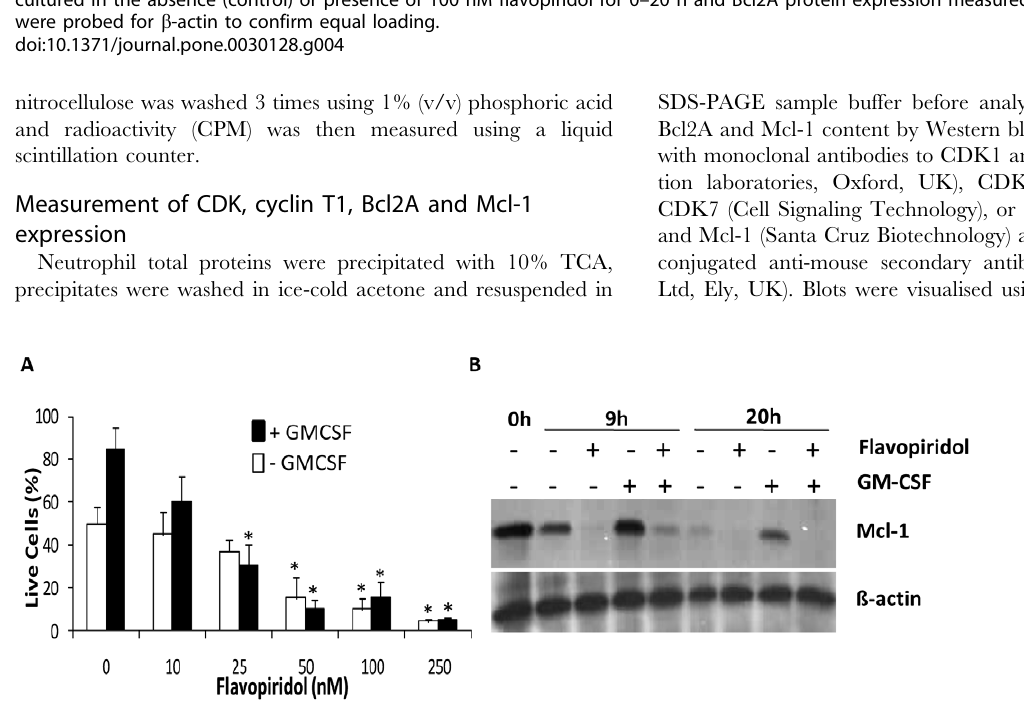
Figure 5. Flavopiridol inhibits upregulation of Mcl-1 by GM-CSF. (a). Neutrophils were incubated with medium alone, or medium containing 100 nM flavopiridol in the absence (open bars) or presence of (filled bars) of 50 ng/ml GM-CSF. Live cells were detected by their ability to retain DiOC 6 and data are mean 6 s.d. of 3 separate experiments. * indicates p , 0.05 for control versus flavopiridol treated cells. (b). The same cells were extracted and measured for Mcl-1 content by western blotting. Blots were probed for b -actin to confirm equal